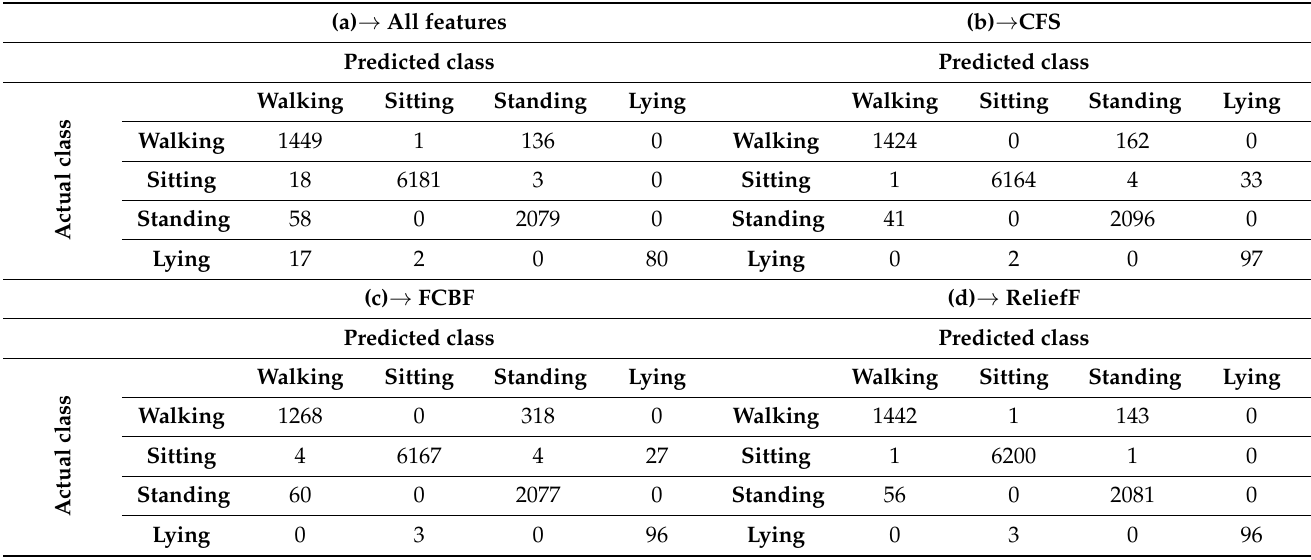
Table 5. Confusion matrix of the PAC system using (a) all features (b) CFS (c) FCBF (d) ReliefF. (a) → All features (b) → CFS Predicted class Predicted